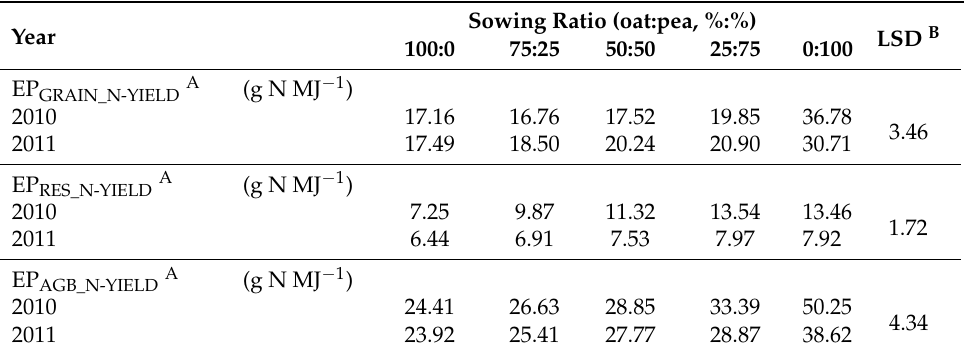
Table 10. Energy efficiency parameters of oat and pea pure crop stands and oat:pea intercrops as affected by sowing ratio and